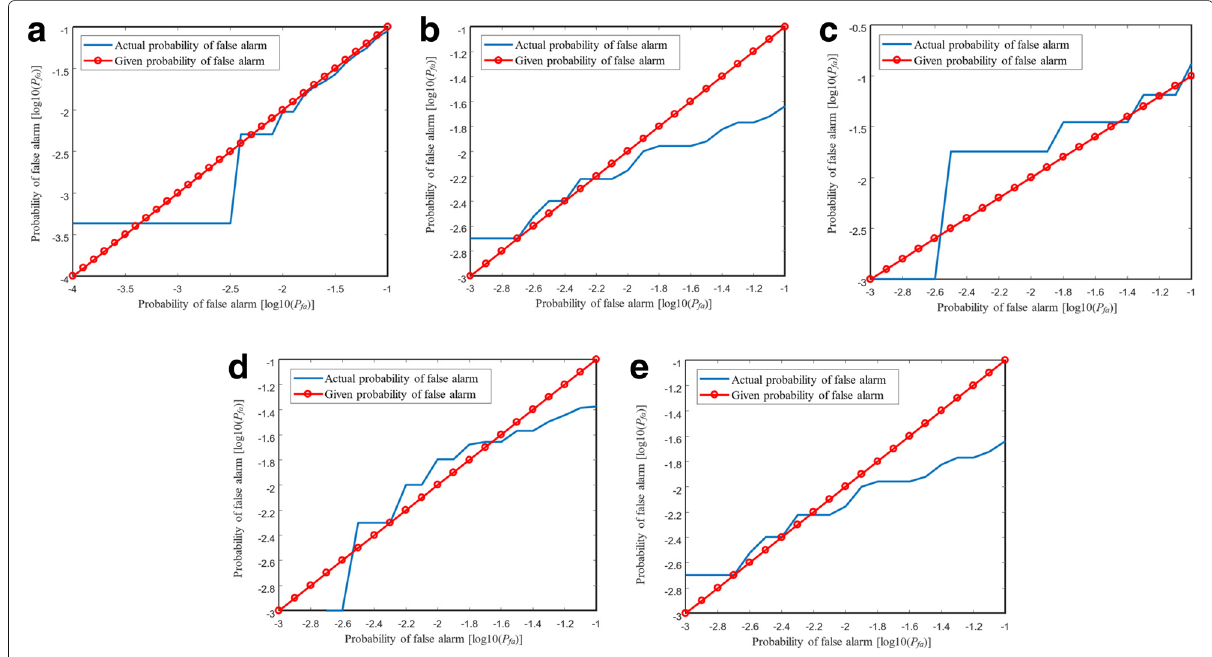
Fig. 6 Comparison between actual P fa and given P fa , a L = 1, M = 1; b L = 10, M = 5; c L = 100, M = 5; d L = 100, M = 20; e L = 100, M =